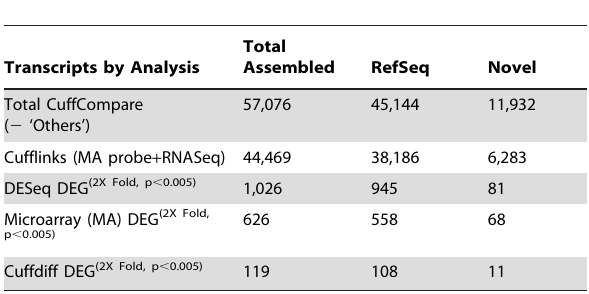
Table 3. Analysis for Differentially Expressed Genes (DEGs) a